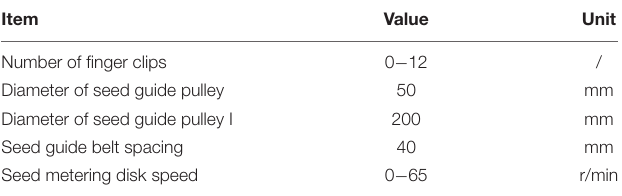
TABLE 1 | Parameters of long-belt finger-clip precision corn seed metering device.